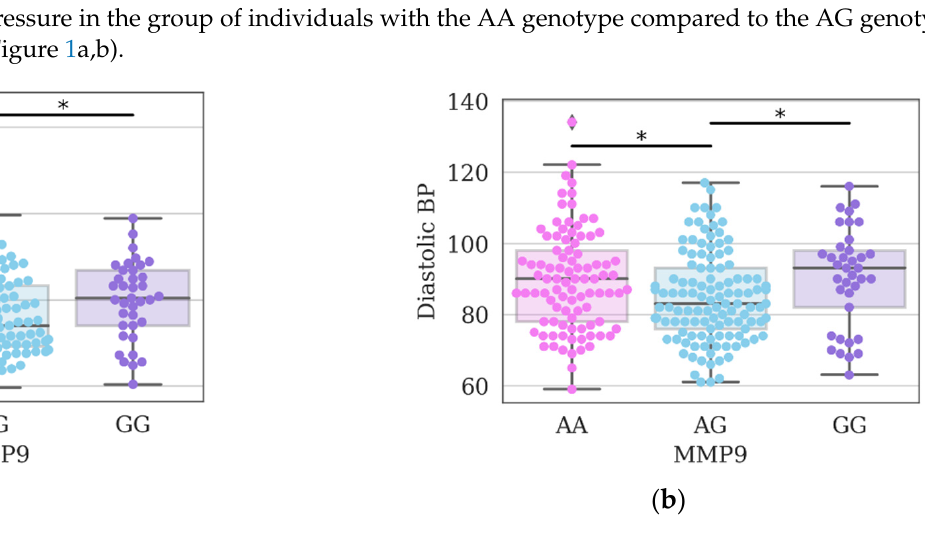
Figure 1. Indicators of systolic ( a ) and diastolic ( b ) blood pressure (BP) in the study group of individuals, depending on the genotypes of polymorphism rs17576 of the MMP9 gene; *—differences were considered significant at a corrected p -value ( p ) < 0.05 (Kruskal–Wallis test, post-hoc Dunn’s test 2-stage FDR correction).